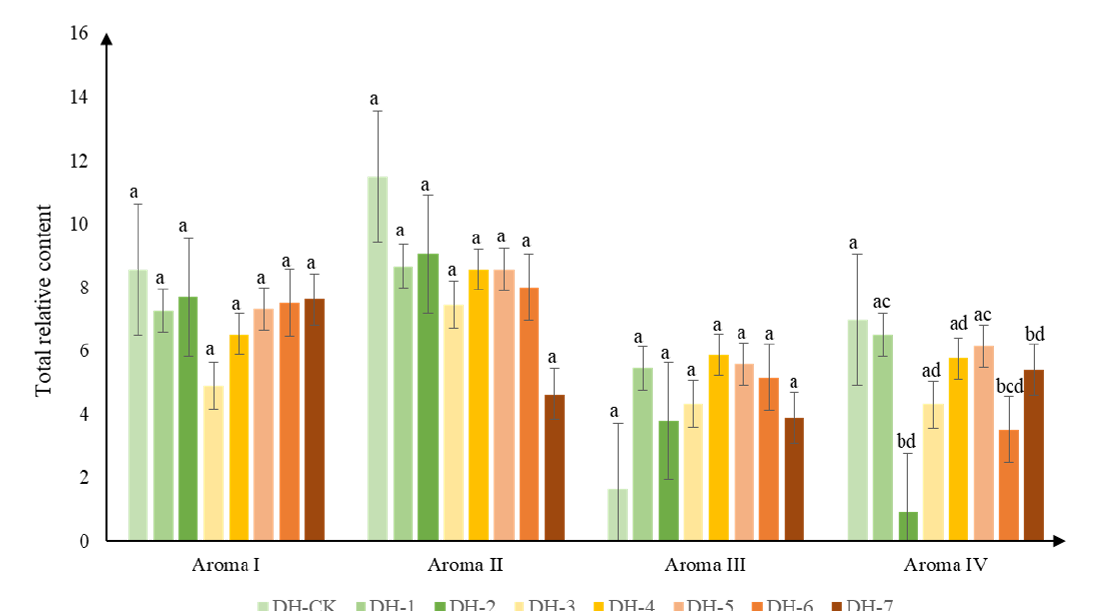
Figure 3. Cluster heat map of aroma compounds in aroma-enhanced Yunnan congou black teas baked at 90 °C (0 – 7 h).